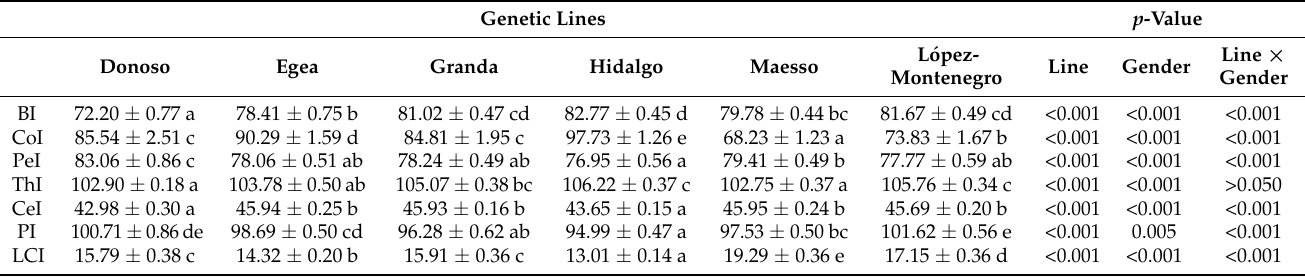
Table 5. Means and standard errors for zoometric indexes taken for animals belonging to the different historical genetic lines of Merino Sheep breed. Analysis of variance ( p -value): gender and genetic line